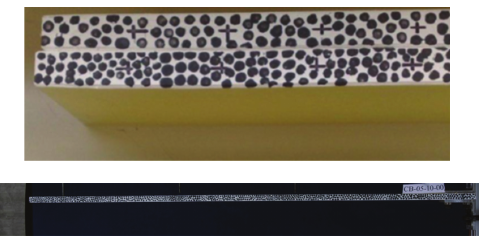
Figure 1: The “structural speckle” marked on the specimen surface of cantilever beam.